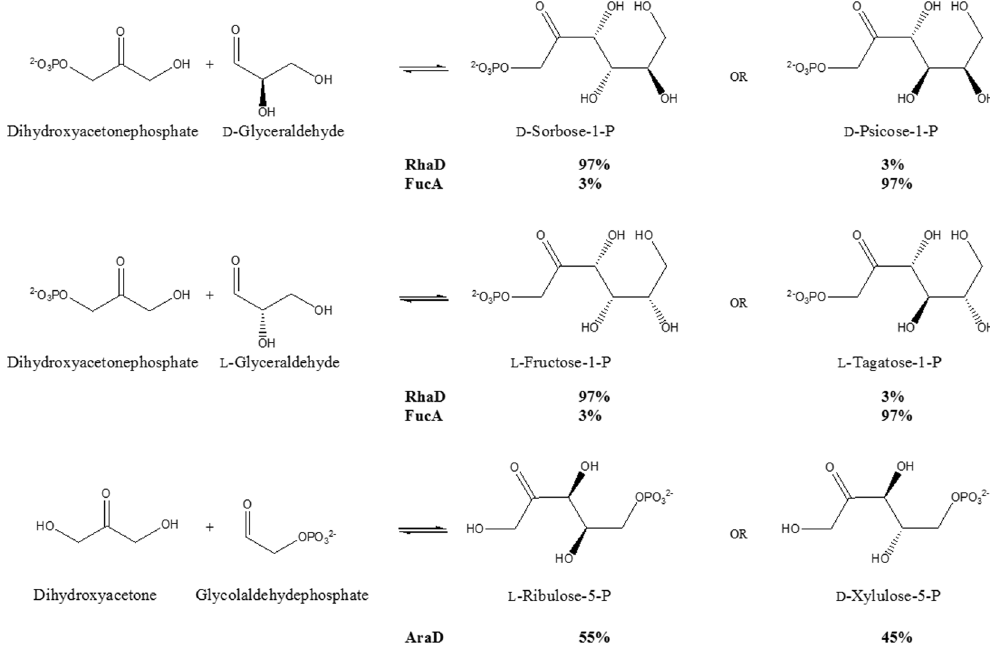
Figure 1. 4-Epimerization reactions of sugar phosphates by class II aldolases and epimerase. The products of the enzymatic reactions of class II aldolases and epimerase are 4-OH epimer forms. Class II aldolases can catalyze the 4-epimerization for the specific